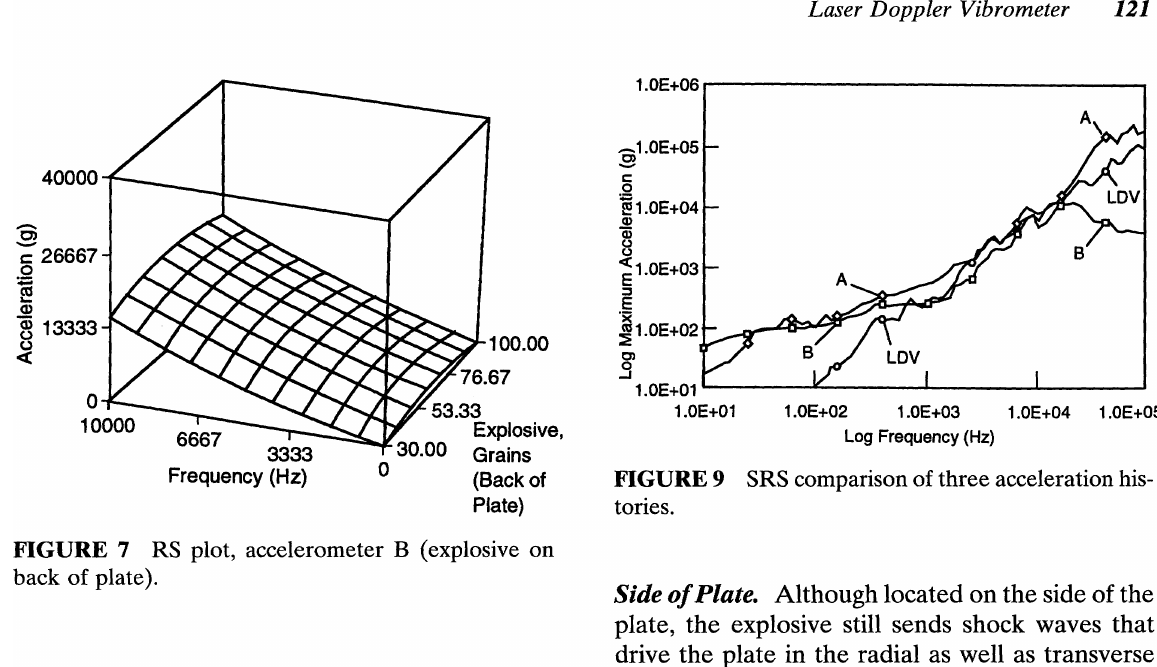
FIGURE 9 SRS comparison of three acceleration his